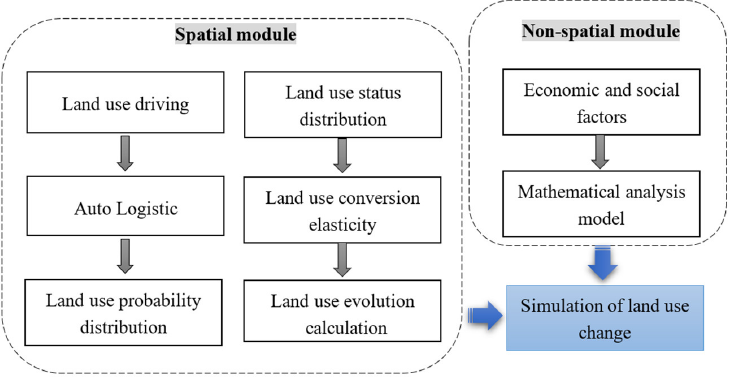
Figure 2. Schematic diagram of the modified CLUE-S mode.